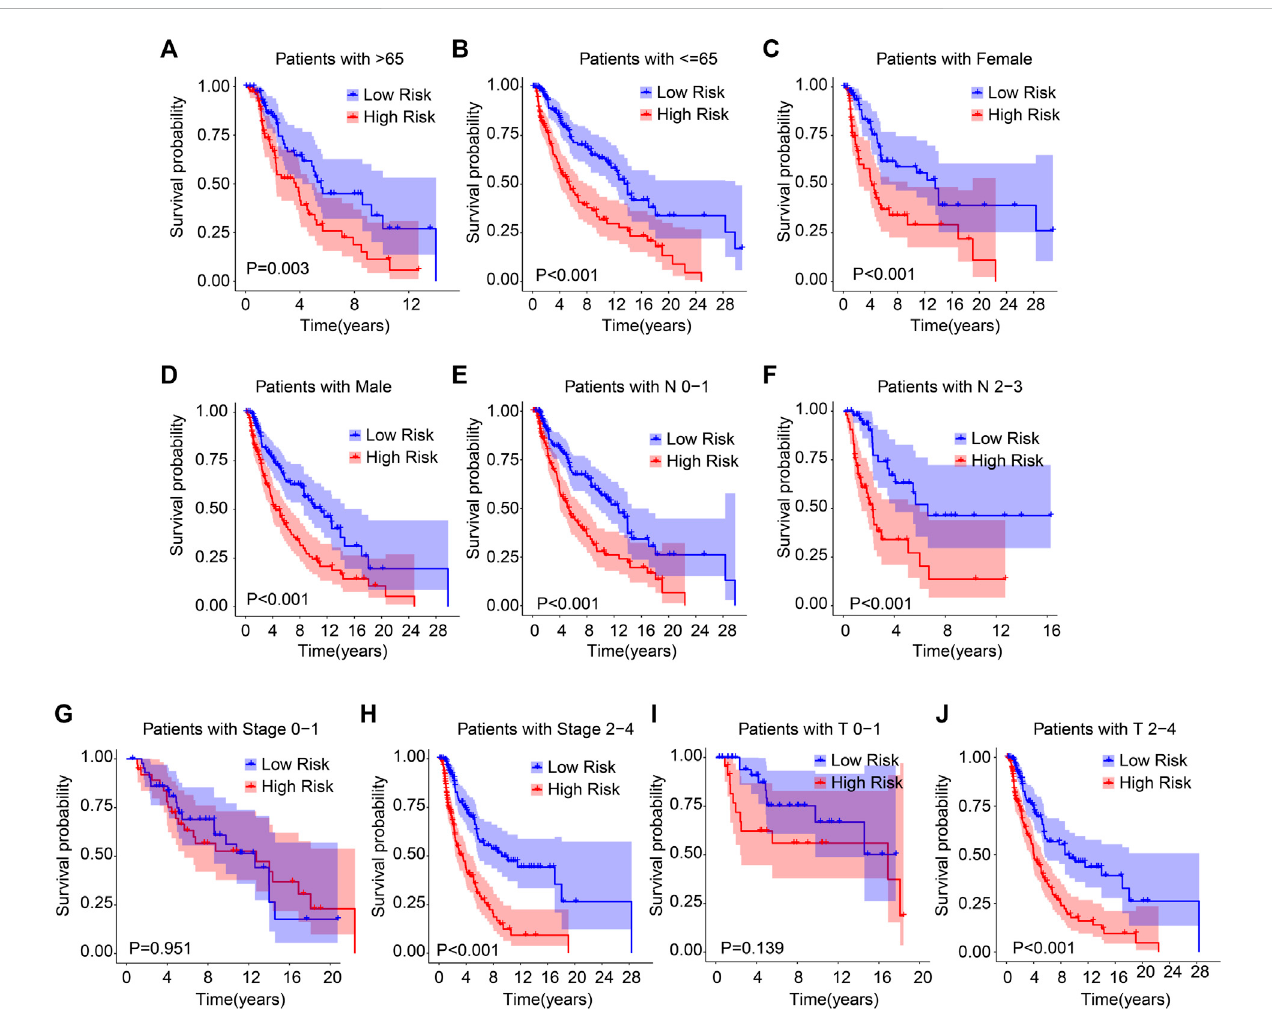
FIGURE 3 The Kaplan – Meier survival analysisof CM patients in the different clinicopathological characteristic subgroups.The Kaplan – Meier survival curve analysis showstheOSrateofpatientsinthelow-andhigh-riskgroupsamongthe (A,B) age(age > 65vs.age ≤ 65), (C,D) gender(femalevs.male), (E,F) N(N0 – 1vs.N 2 – 3), (G, H) stage (stage 0 – 1 vs. stage 2 – 4), (I, J) T (T 0 – 1 vs. T 2 –